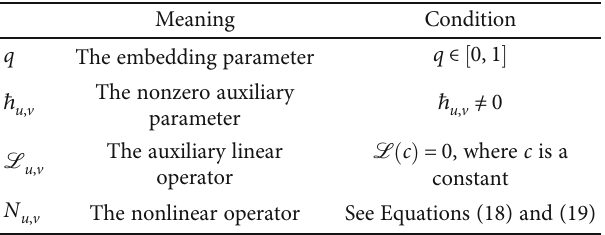
Table 3: Parameters and variables in equation homotopy maps given in Equations (16) and